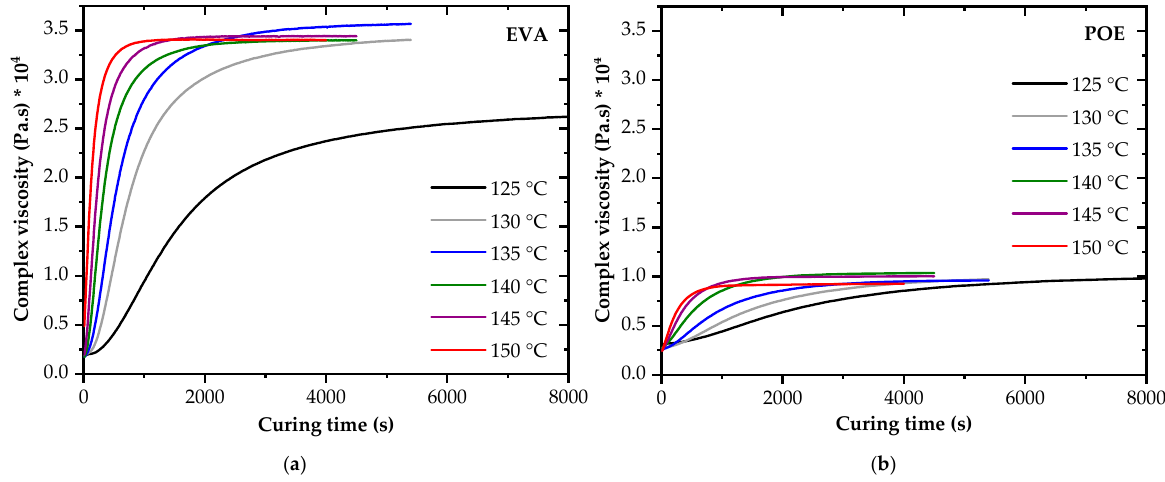
Figure 5. Complex viscosity of EVA ( a ) and POE ( b ) as a function of curing temperature and